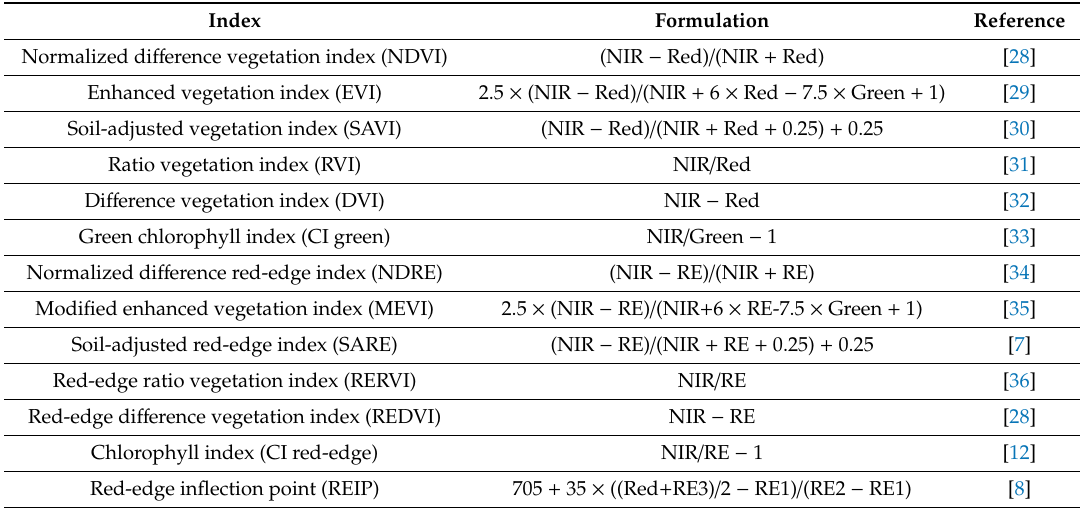
Table 4. Algorithms and references for VIs for the agriculture application of fused, Planet, and Sentinel-2